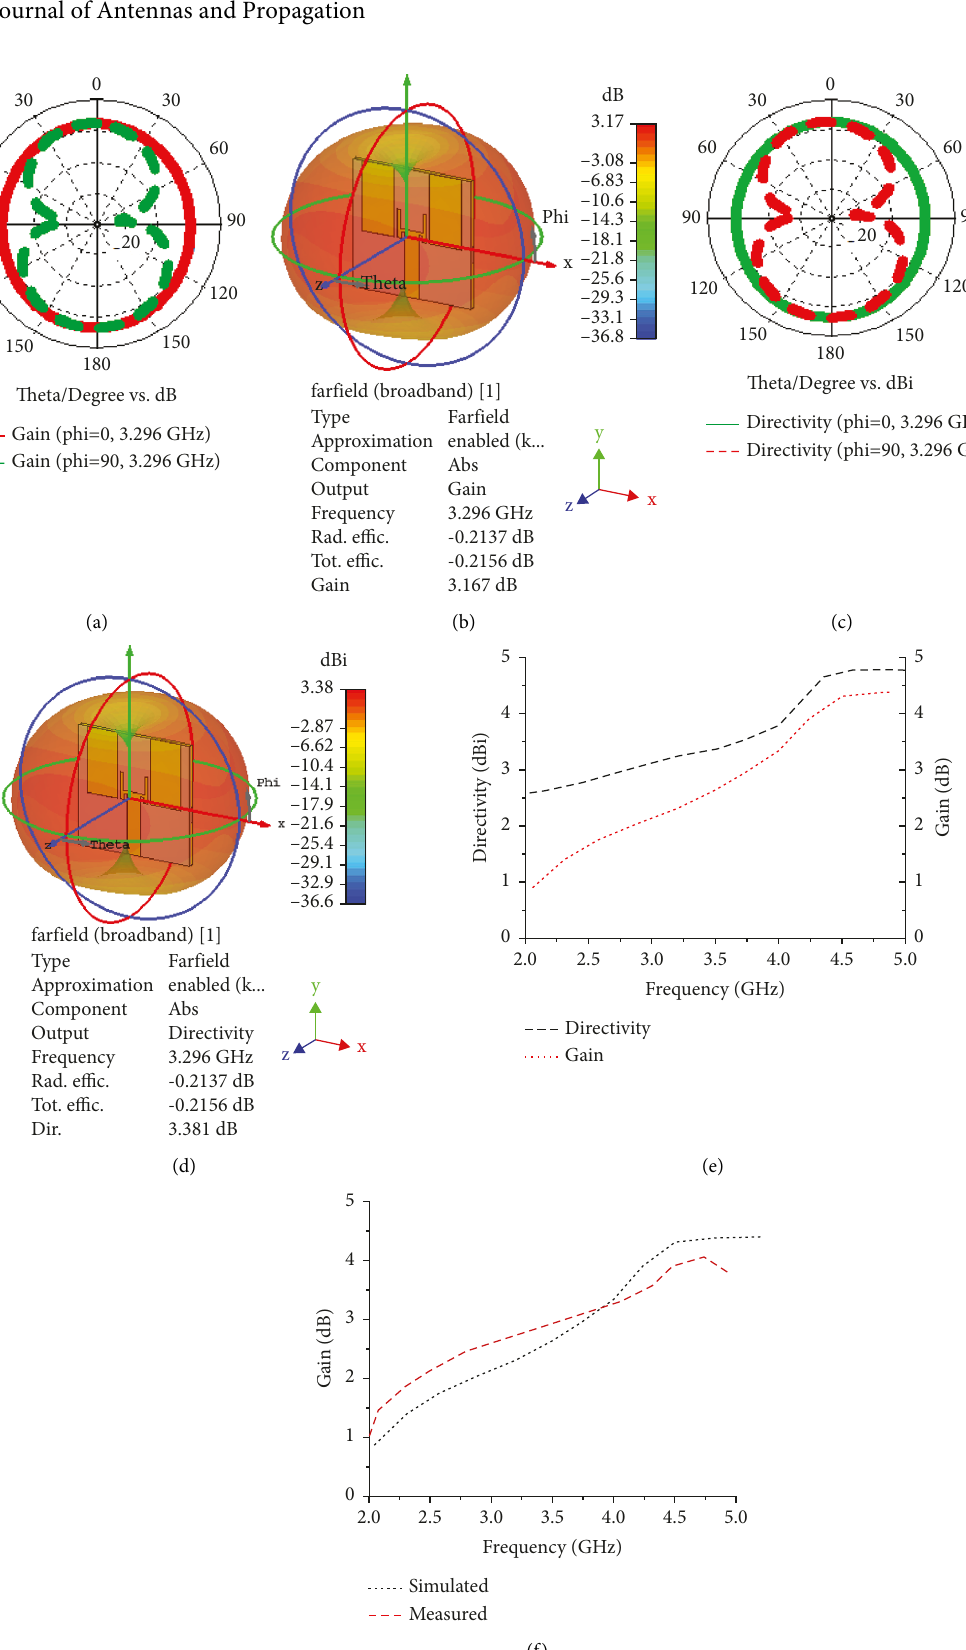
Figure 6: Gain and directivity of the inset fed MPA. (a) Gain (polar). (b) Gain (3D). (c) Directivity (polar). (d) Directivity (3D). (e) Simulated gain and directivity. (f) Simulated and measured